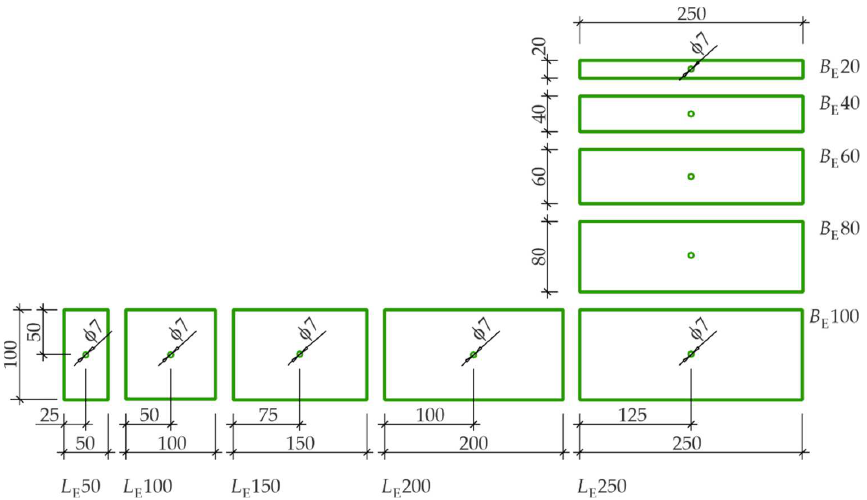
Figure 2. Stainless-steel counter electrodes used in the EIS tests on the impact of the auxiliary electrode geometry on the obtained shapes of impedance spectra.